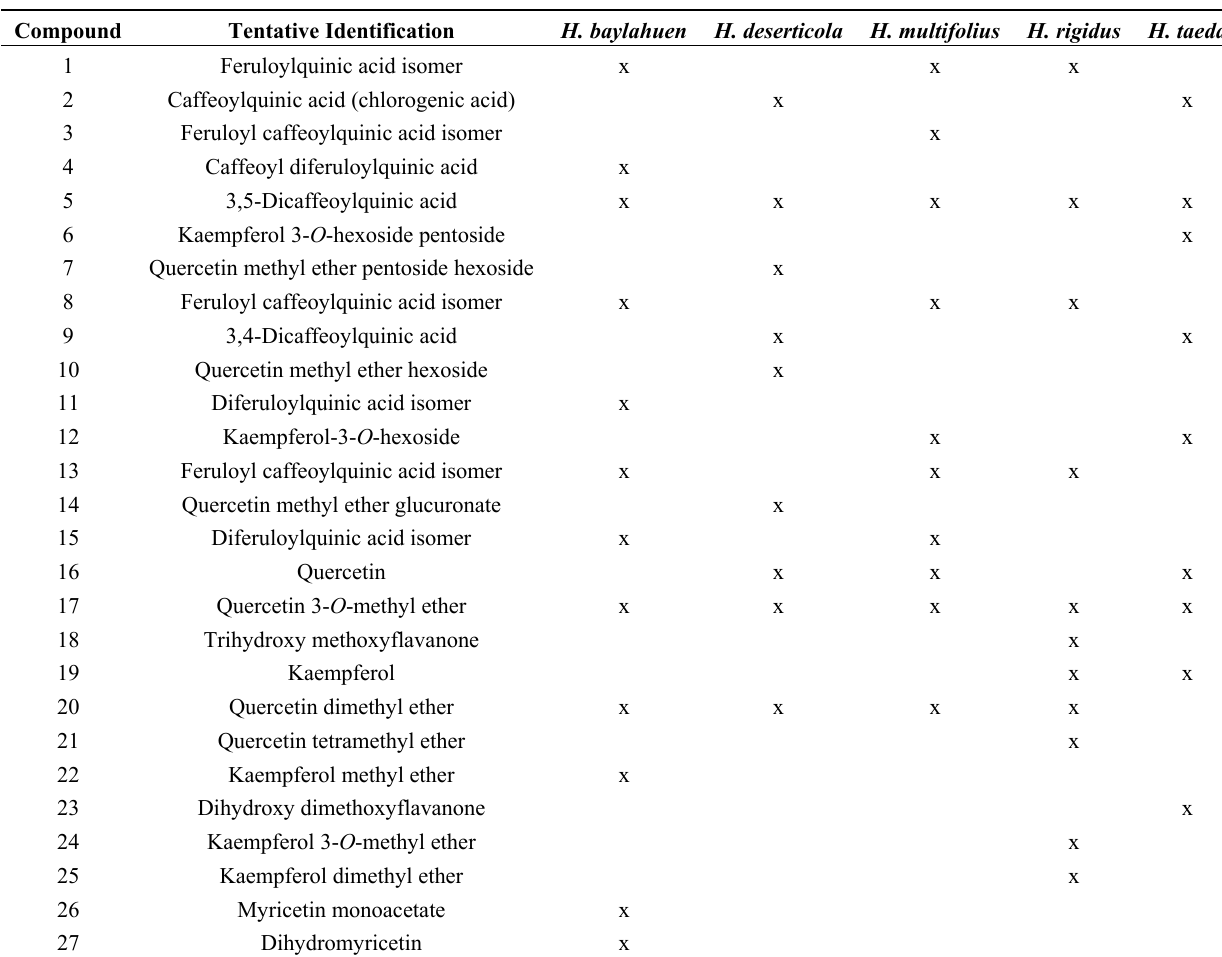
Table 2. Distribution of the phenolic compounds in “baylahuen” tea and methanol extract by HPLC-DAD-ESI-MS